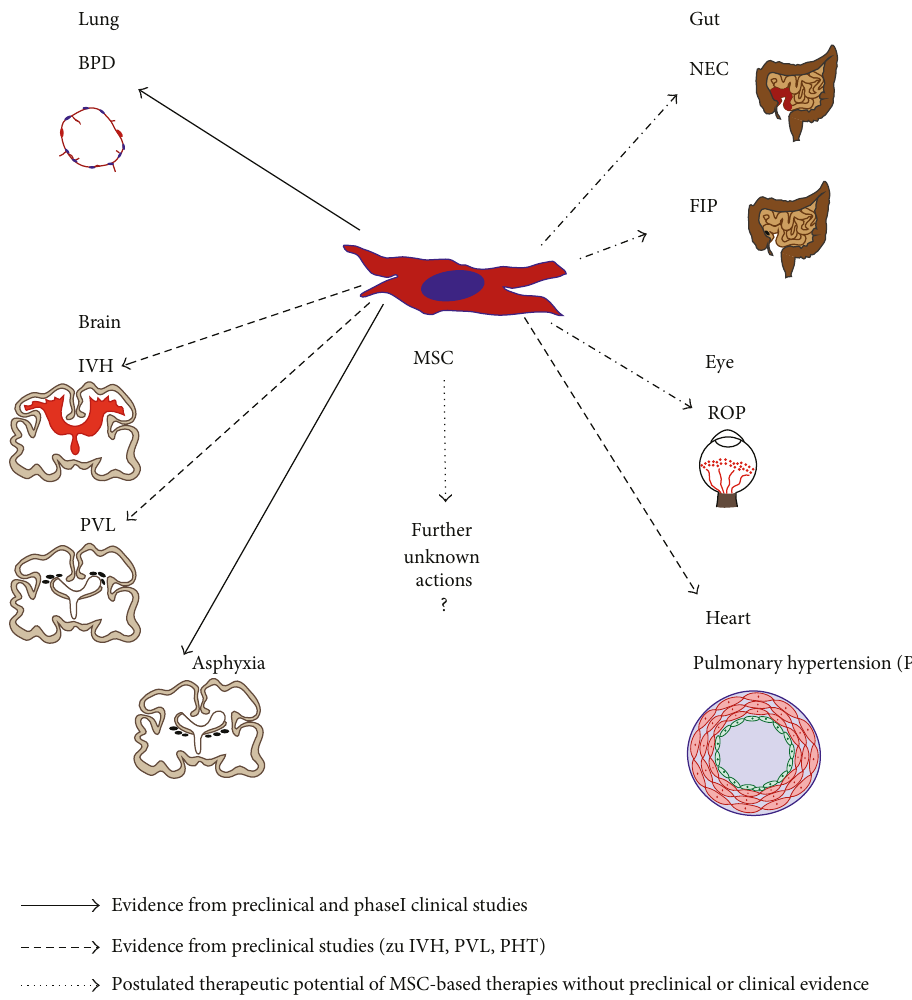
Figure 3: Therapeutic potential of MSC therapy in the preterm and newborn infant: beyond prevention or therapy of lung injury following preterm birth, MSC-based therapies have a therapeutic potential for all in fl ammatory diseases of the preterm and newborn infant. The scheme summarizes the current status of MSC-based therapies for the lung, brain, gut, eye, and cardiopulmonary system. The scienti fi c knowledge is separated into evidence from phase I clinical trials and preclinical studies mainly in rodents and a presumed therapeutic